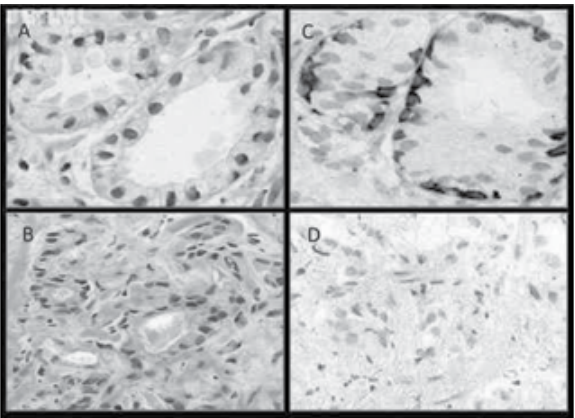
Figure 5 – ASAP (A) ASAP; (B) ASAP; (C) immunostaining using a basal cell antibody cocktail (34 β E12 + p63) rules out cancer; (D) absence of basal cell layers, as assessed by immunostaining using 34 β E12 + p63 confirms the diagnosis of adenocarcinoma. ASAP: atypical small acinar proliferation.